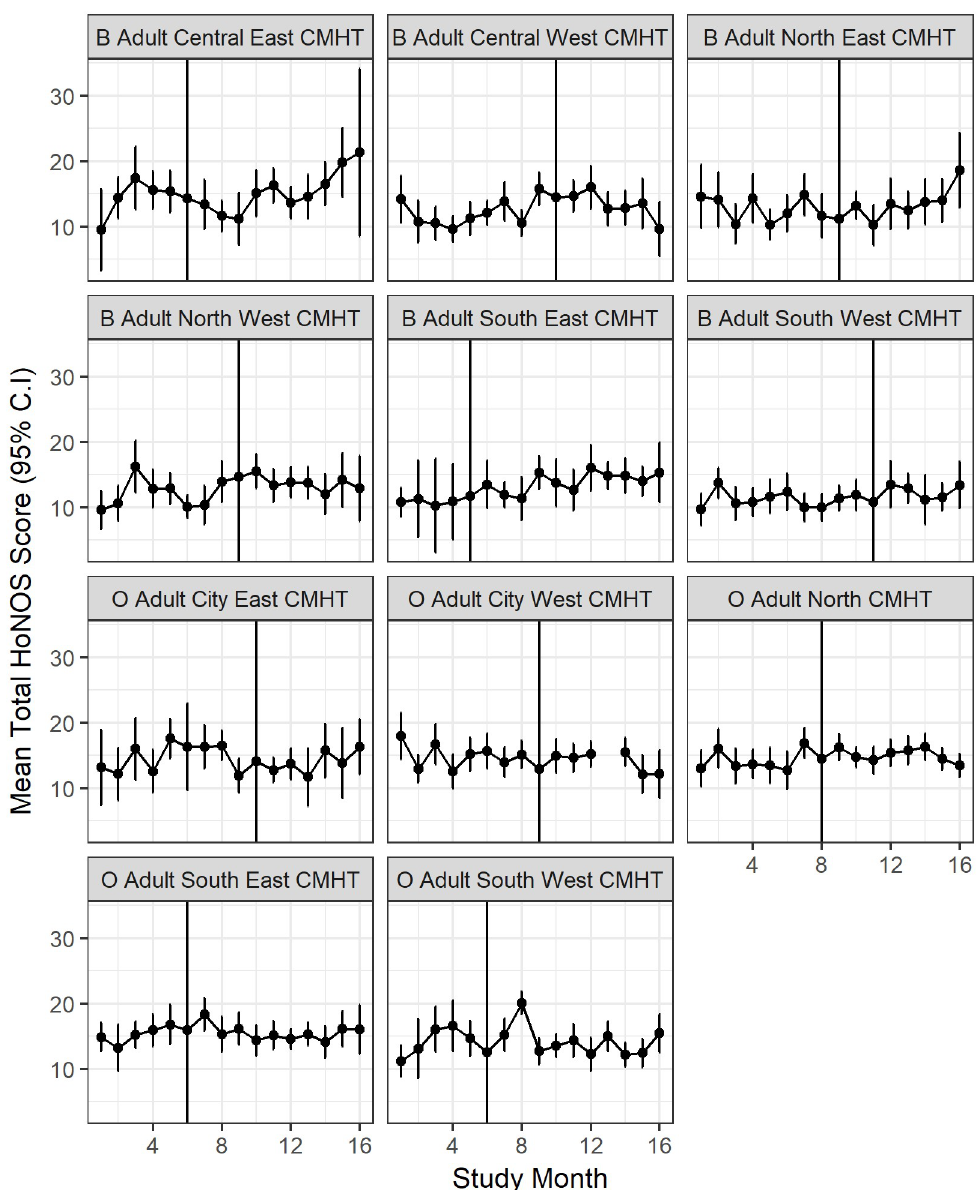
Fig 1. Mean plots with 95% confidence intervals (C.I.) of the total HoNOS scores plotted against the calendar time (study months) at each CMHT for the OXTEXT-7 study. Data to the left of the vertical line occurred before the intervention and data to the right after the intervention was